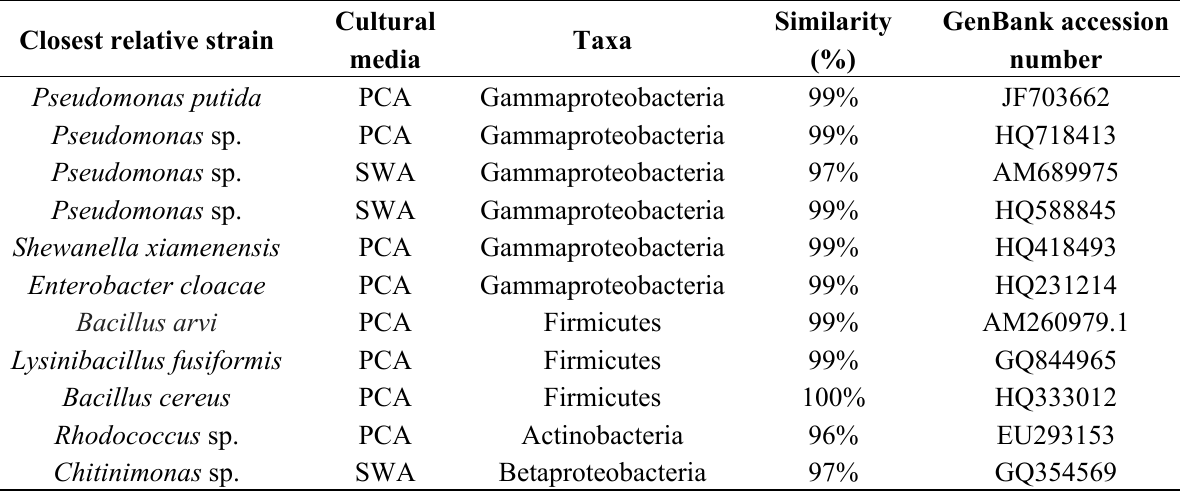
Table 2. Identification of partial 16S gene sequences from bacterial strains isolated from fouled filtration membrane. PCA, plate count agar medium; SWA, agarized synthetic wastewater